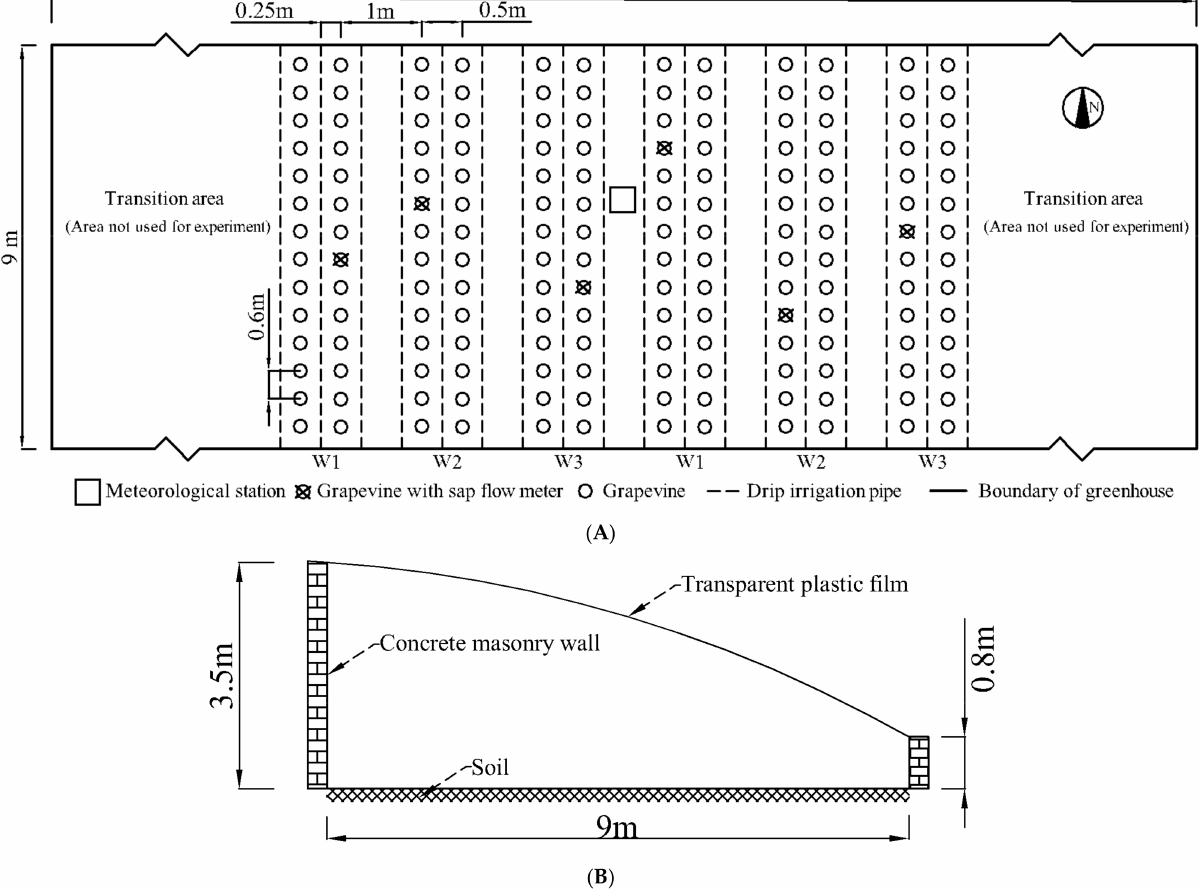
Figure 2. ( A ) A schematic drawing of the plant distribution in the greenhouse; ( B ) the side view of the